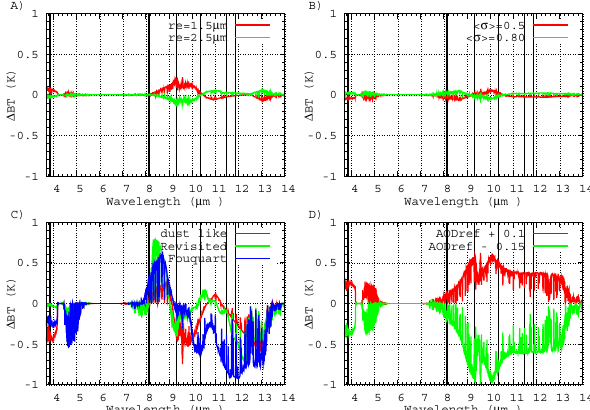
Figure A4. Sensitivity of IASI brightness temperature to (a) a vari- ation of ± 25% of the effective radius r eff (designated r e in the diagram); (b) a variation of ± 25% of the standard deviation σ g ; (c) a change in the refractive index (i.e. composition); (d) an AOD variation of + 0.1 ( ∼ 25%) and − 0.15 ( ∼− 37%). Reference con- ditions: AOD at 10µm = 0.4, mean aerosol layer altitude = 2700m, r eff = 2µm, σ g = 0 . 65, and refractive index is MITR.